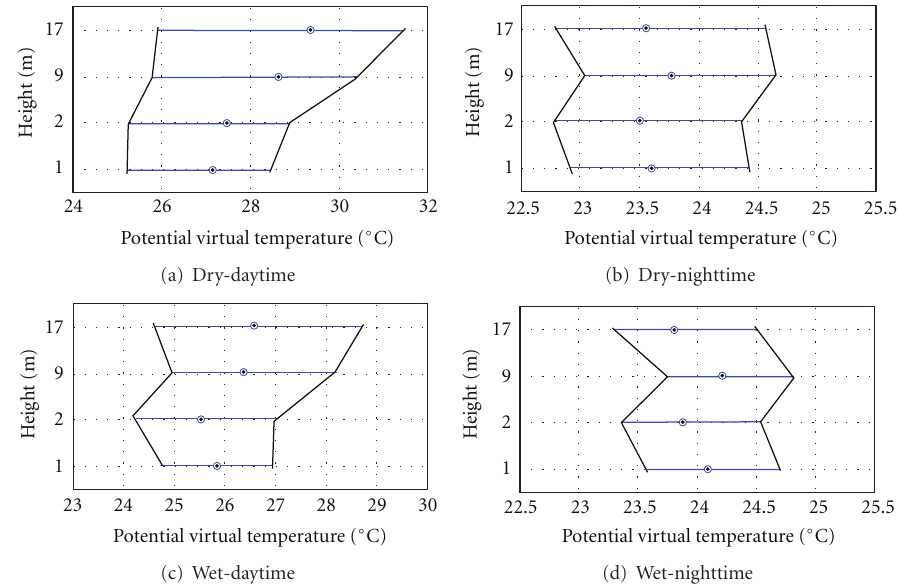
Figure 8: Boxplot of the virtual potential temperature vertical profile for dry ((a), (b)) and wet periods ((c), (d)) of the 2006 during night ((b), (d)) and daytime ((a), (c)), on the slope area of DRAINO System tower (south face; see Figure